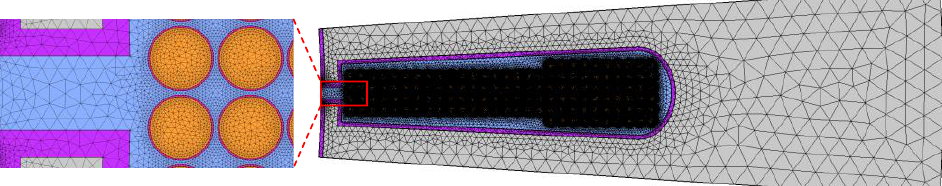
Figure 10. The location of 11 turns in a slot.